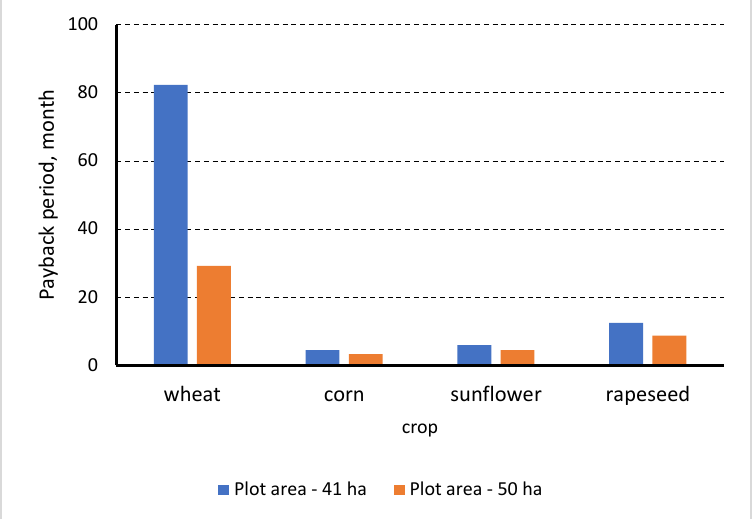
Figure 8. Payback periods for the retrofitting of the conventional irrigation system.